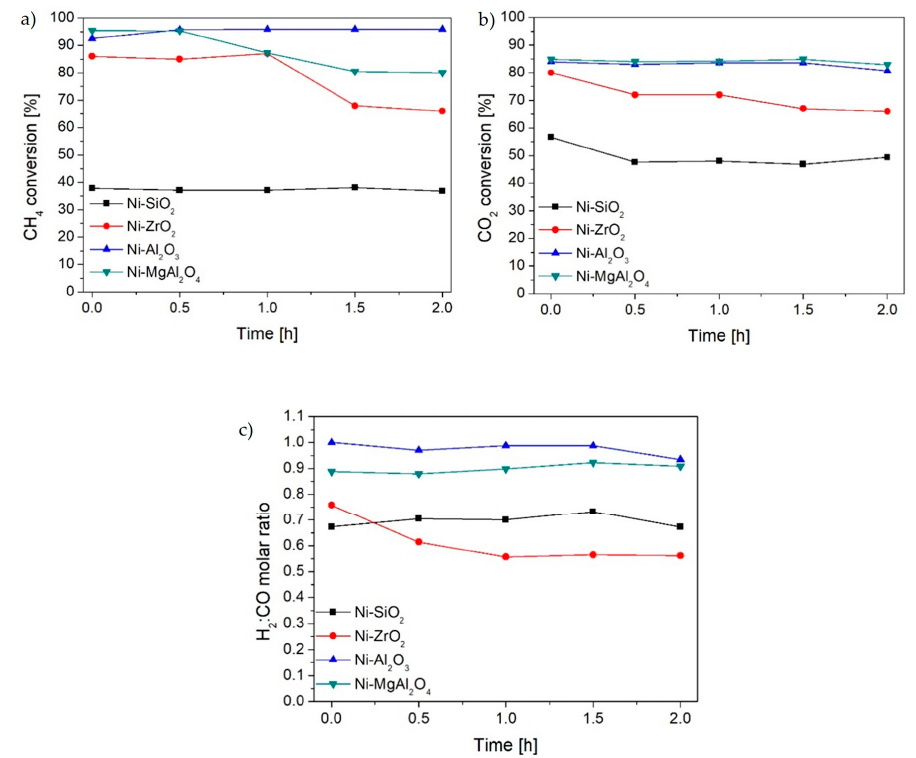
Figure 2. ( a ) Methane conversion, ( b ) carbon dioxide conversion, and ( c ) H 2 /CO molar ratio for nickel